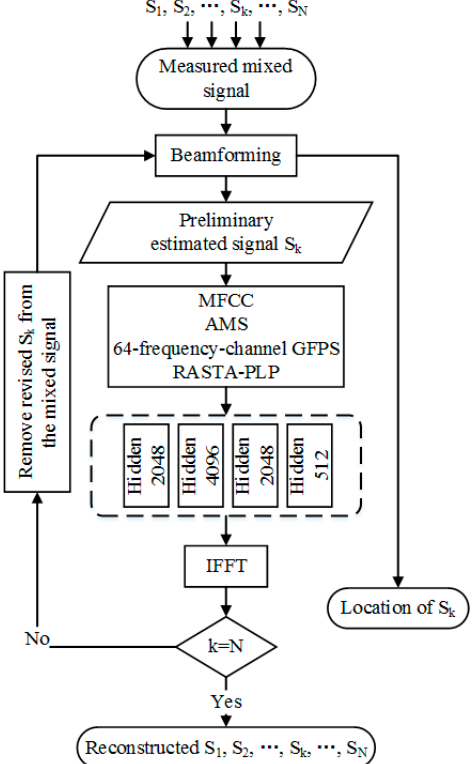
Figure 1. Schematic of the proposed method.